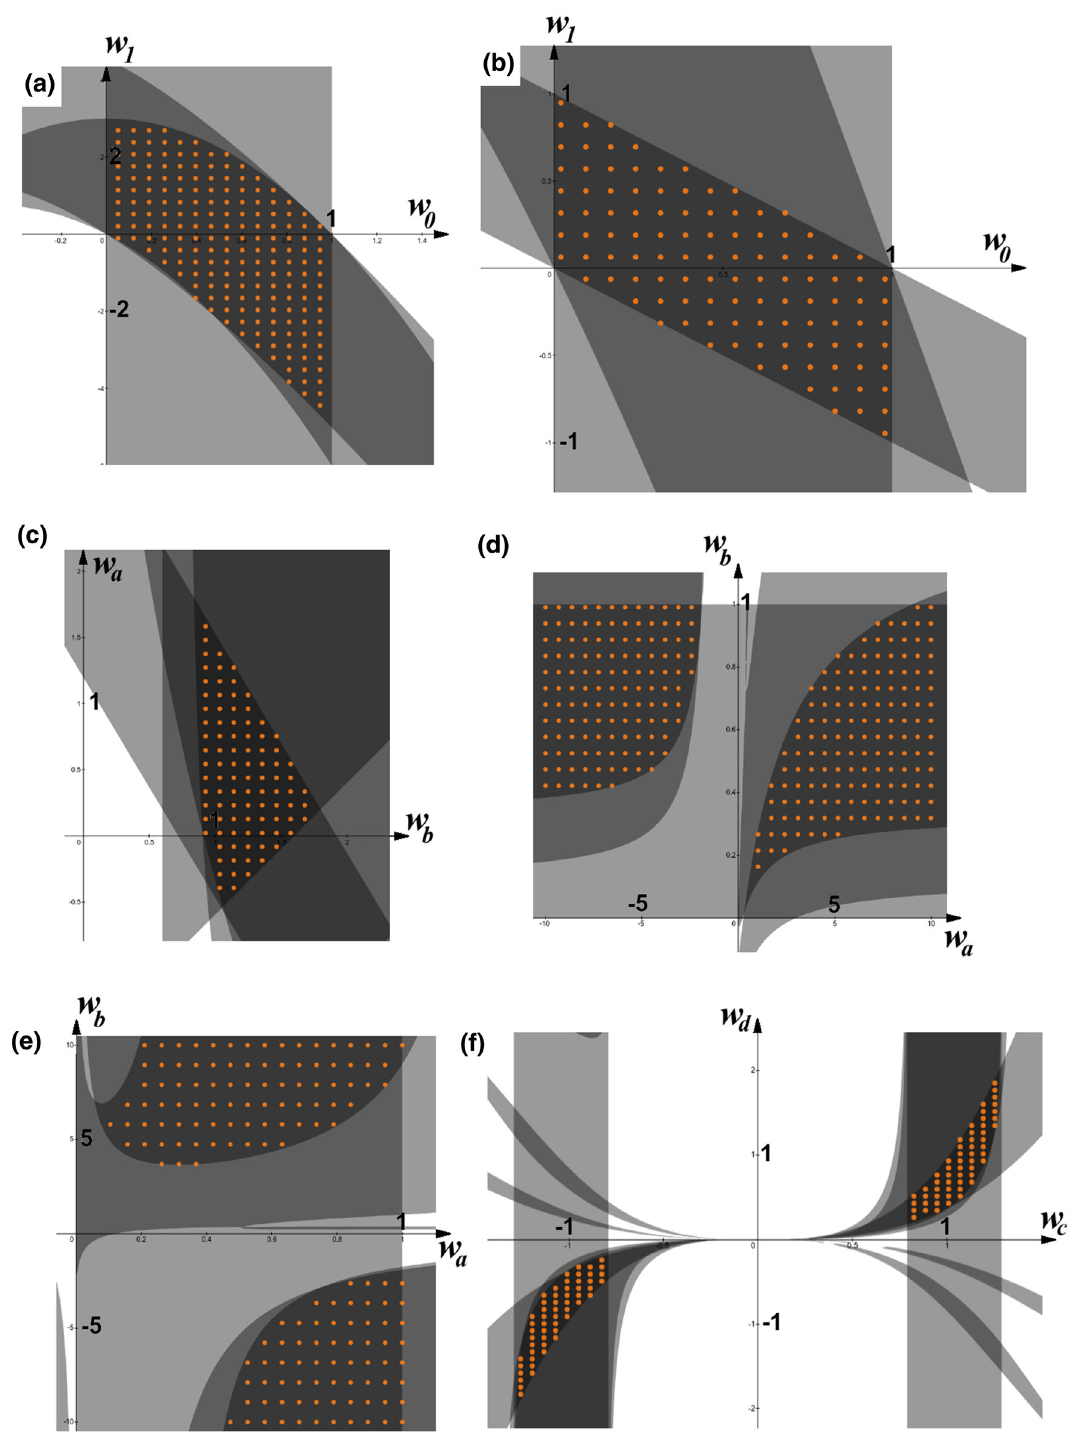
) p = w a w b − w 0 [24] for p = 1, w 0 = − 0 . 6 and ( a c w 0 − w a in plot ( e ) and [39] a 0 w = − 0 . 6 and w = − 1 in plot ( f ). In all plots the symbol w b 0 0 on the axis denotes the present value of the w( a ) function, whereas the other w a − w 0 ) p = w b symbolsrefertoparametersinthecorresponding w( a ) w a w 0 − w b in plot ( d ), a 0